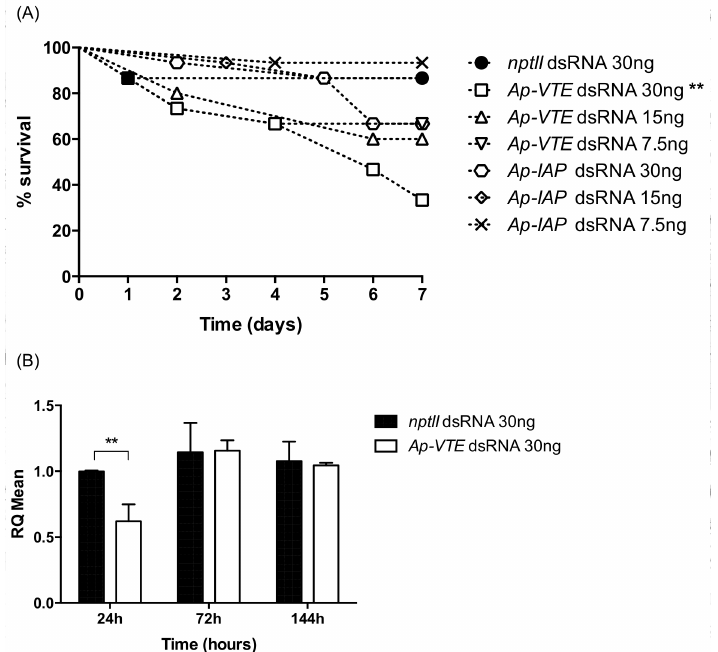
Figure 2. ( A ) Aphid survival after injection of Ap-VTE or Ap-IAP dsRNAs ( n = 15 per treatment). ( B ) Relative expression of Ap-VTE mRNA in injected aphids. RQ set to 1.0 for nptII control 24